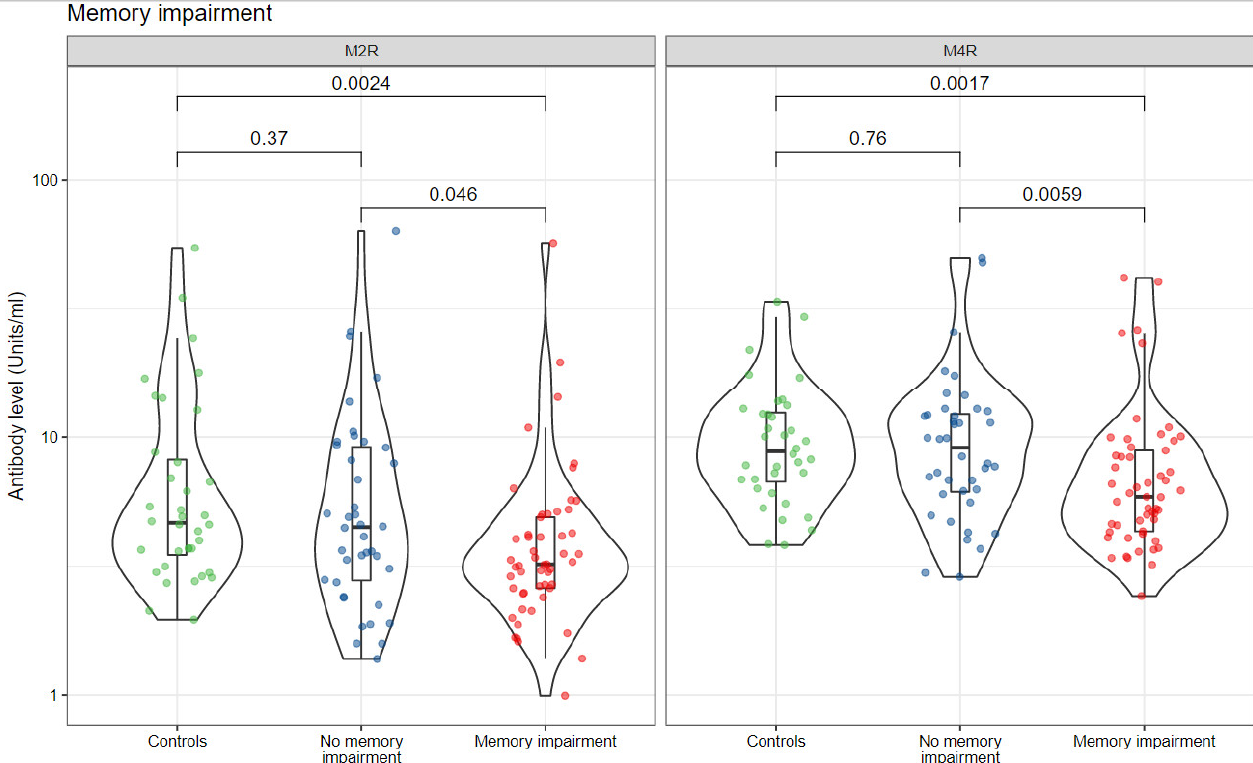
Figure 1. Autoantibodies against autonomic nervous system receptors are correlated with memory impairment in symptomatic women with SBIs. Individual measurements are shown as dots, summary data as box plots, and the distributions as violin plots. Green dots: healthy controls; Blue dots: silicone-breast-implant patients without clinical manifestations; red dots: silicone-breast-implant patients with clinical manifestations.